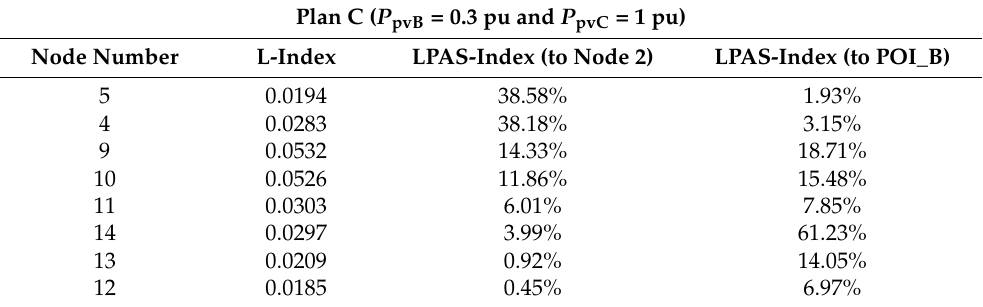
Table 3. The values of L-index and LPAS-index of load nodes under Plan C (Load multiple lm = 1